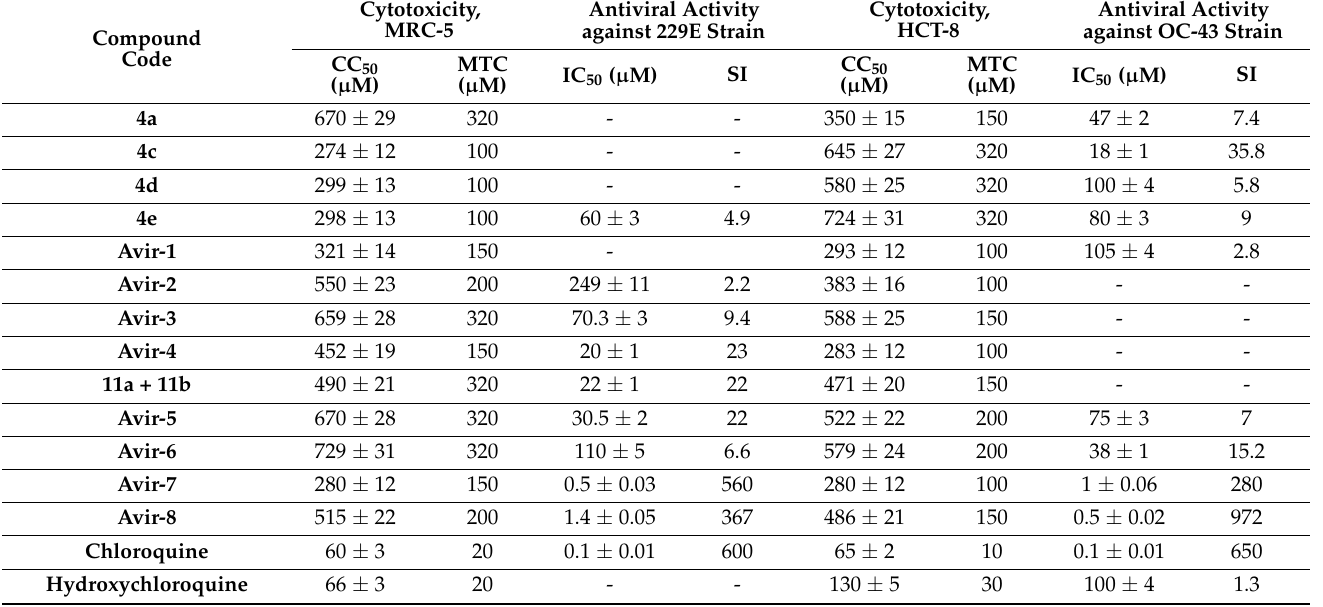
Table 3. Cytotoxicity (against MRC-5 and HCT-8 cell lines) and antiviral effect (against